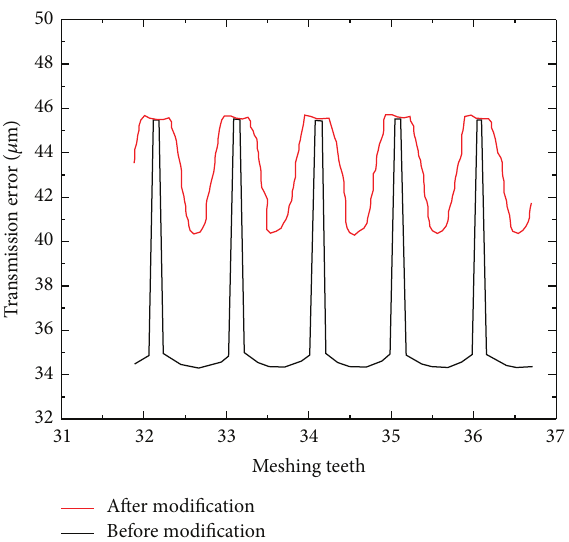
Figure 8: Maximum equivalent stress history after and before gear modification on the rated conditions based on ANSYS